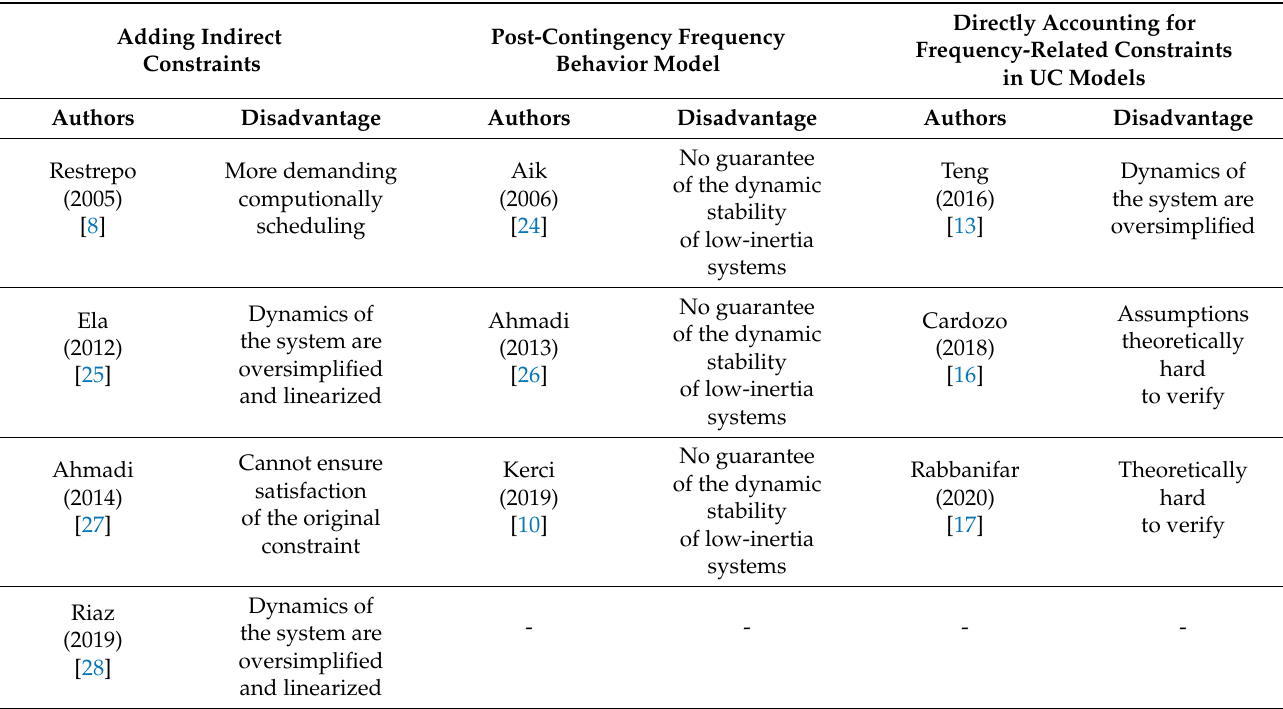
Table 1. Ways to account for frequency in UC and associated